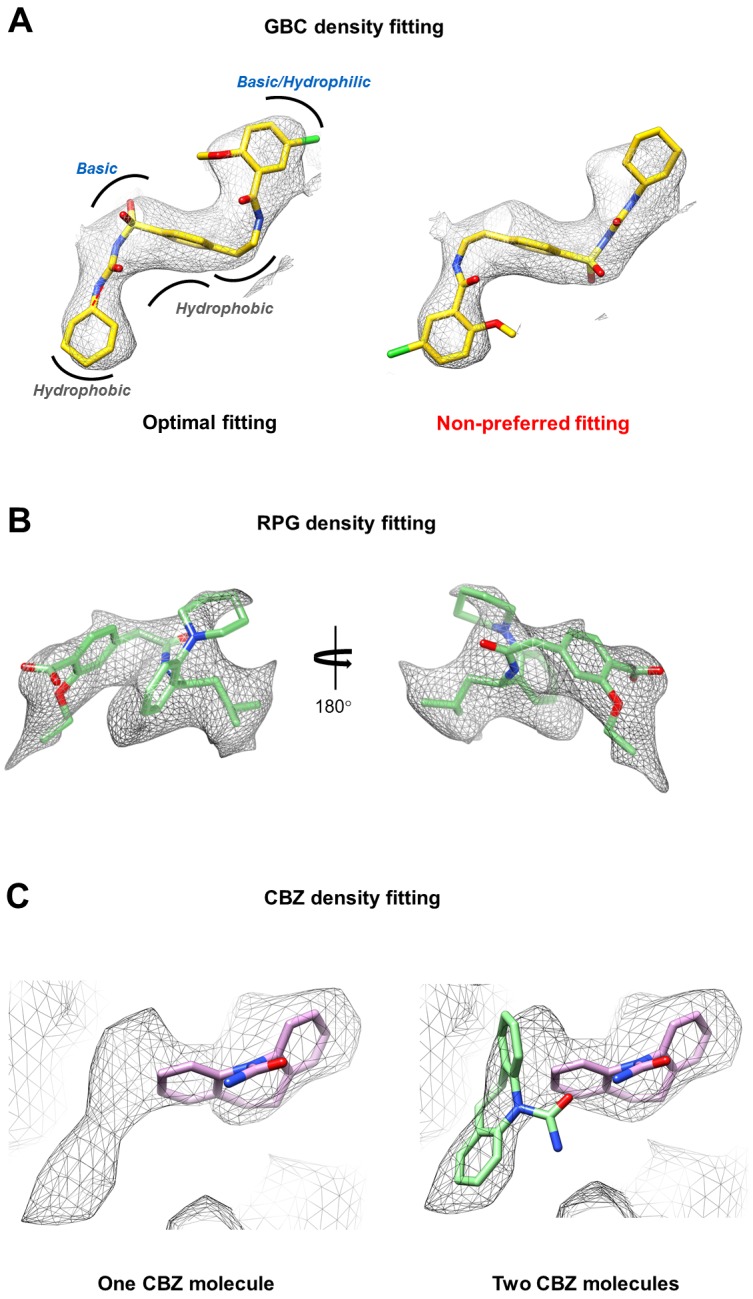
Density fitting for GBC, RPG, and CBZ.(A) CryoEM density of GBC from the focus-refined SUR1 map contoured to 8.5σ. Left: optimal fitting of the GBC structure into the density. The electrostatic nature of the residues in the binding pocket surrounding GBC (see Figure 3B) are shown to demonstrate general electrostatic mismatch with GBC if the molecule were modeled into the density in the flipped orientation by 180° shown on the right. (B) CryoEM density of RPG from the focus-refined SUR1 map contoured to 9σ with RPG fitted into the density. (C) CryoEM density of CBZ from the locally refined SUR1 map contoured to 8.5σ. Left: A CBZ molecule is placed into one end of the density to illustrate that one stationary CBZ molecule cannot account for the full ligand density observed. Right: Two CBZ molecules are placed in the density to show sufficient density to accommodate two CBZ molecules.